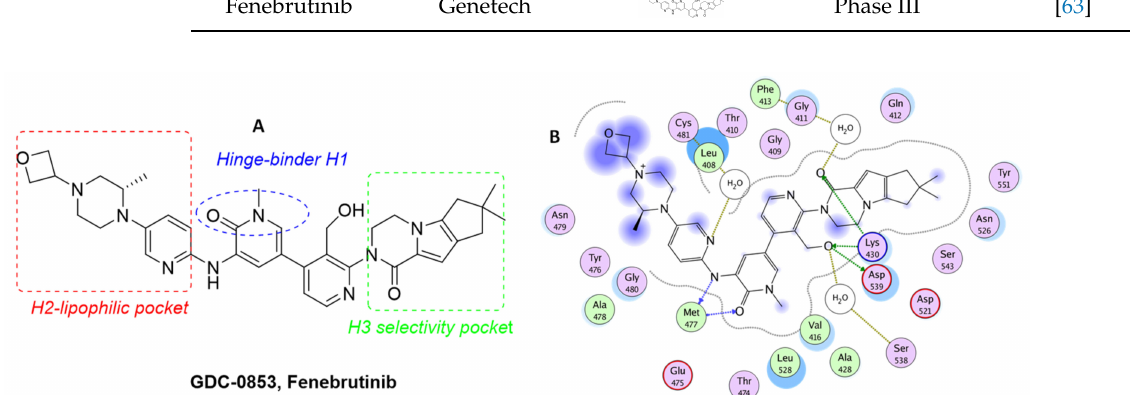
Figure 4. ( A ) Schematic representation of interaction of BTK and Fenebrutinib; ( B ) Ligplot of BTK–Fenebrutinib crystallo- graphic complex (PDB code: